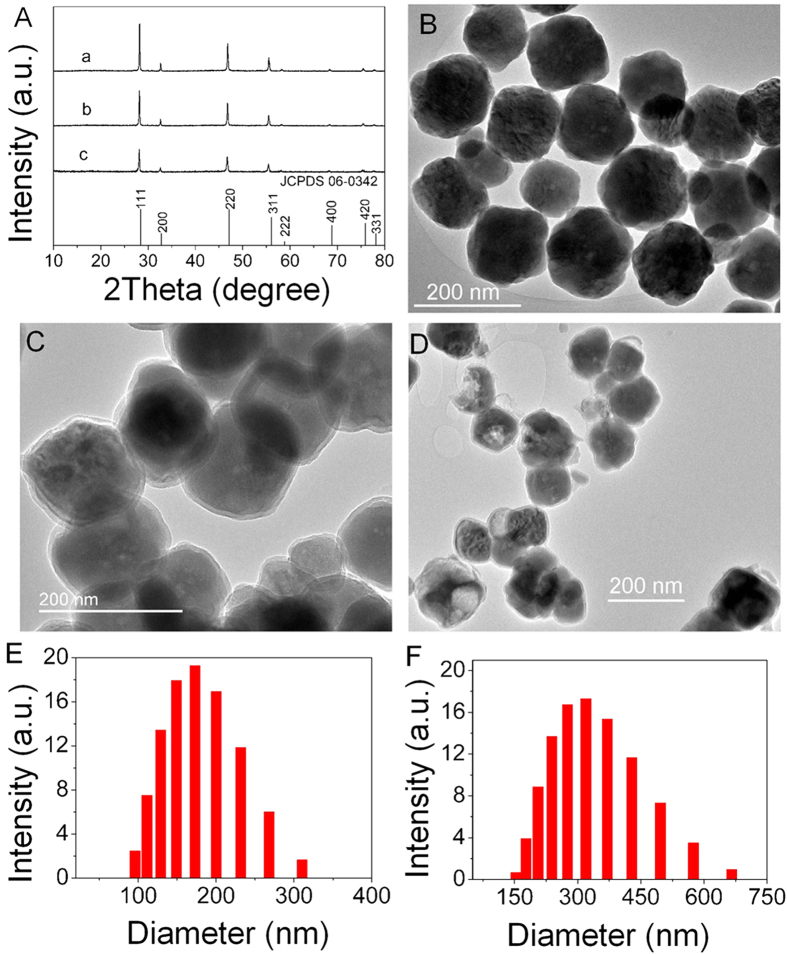
(A) XRD patterns of UCNPs (a), UCNPs@SiO2 (b) and UCNPs@SiO2@PMAA (c). TEM images of UCNPs (B), UCNPs@SiO2 (C) and UCNPs@SiO2@PMAA (D). Histograms of the size distributions of UCNPs@SiO2 (E) and UCNPs@SiO2@PMAA (F).